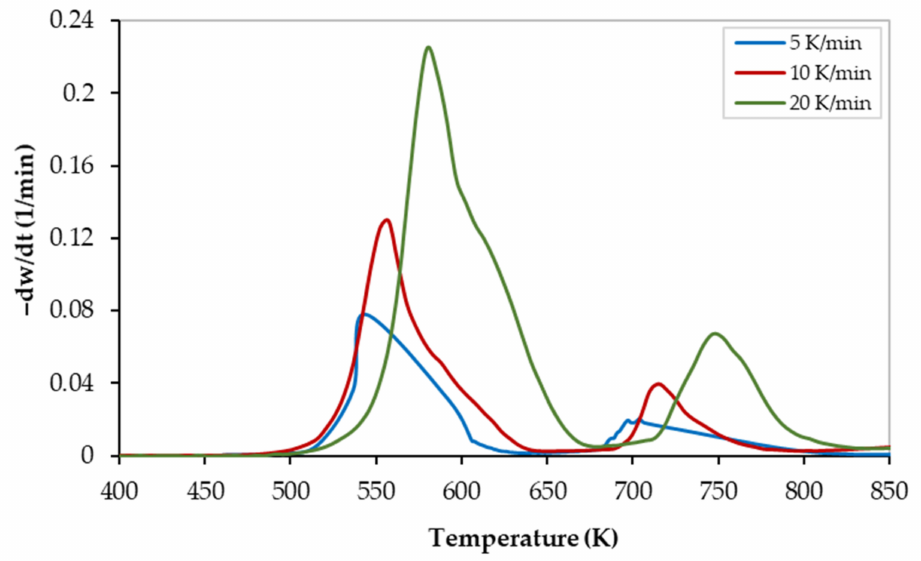
Figure 2. Derivative-thermogravimetric (DTG) curves of the PVC pyrolysis at different heating rates.